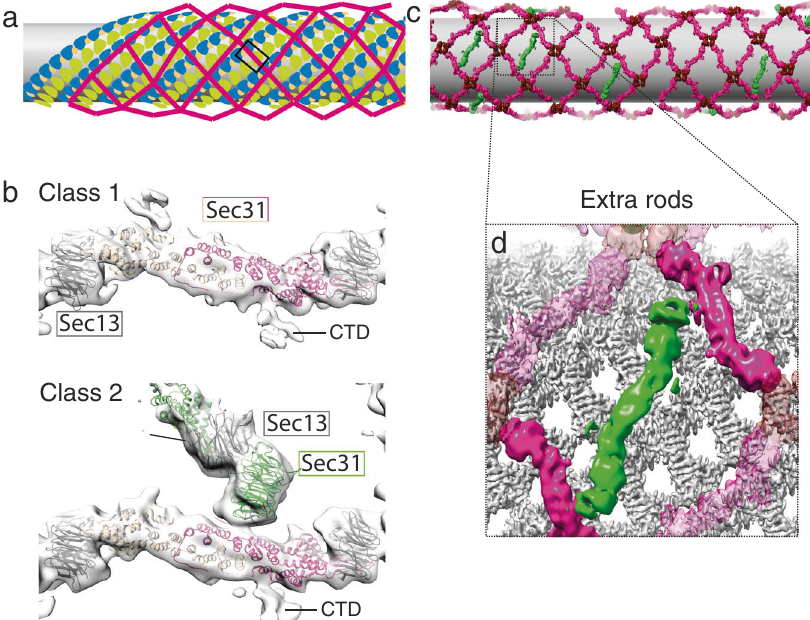
Fig. 4 Architecture of COPII rods organised in a right-handed manner. a Schematic representation of coat architecture, with right-handed rod positions highlighted in the box. b Top panel: top view of the 13 Å subtomogram average of the COPII right-handed rod with no extra density at the dimerisation interface, with rigid-body fi tted models (PDB 2PM9). The dimerising protomers are shown in dark and light pink, Sec13 in grey. The CTD is visible in these rods. Bottom panel: the same view of a class of right-handed rods that displays an attachment of another rod. The Sec13 – 31 beta propeller tandem is fi tted (Sec31 in green and Sec13 in grey). Sigma threshold for contouring was set at 2.6. c Averages of vertices (dark red), left and right-handed rods (pink) are placed in their aligned positions and orientations in a representative tomogram. Extra rods are placed in green, and display random distribution, but unique orientation. d Enlargement of the placed object, with the placed inner coat (grey), showing that extra rods orient roughly parallel to the inner coat lattice direction.